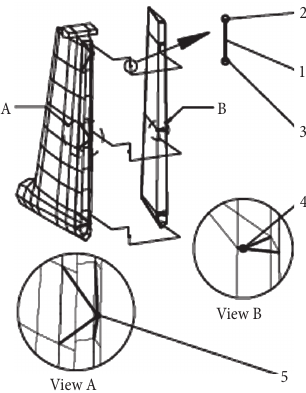
Fig. 2. Modelling of control surfaces hinges: 1 – beam element; 2, 3 – nodes of the beam element; 4, 5 – multipoint